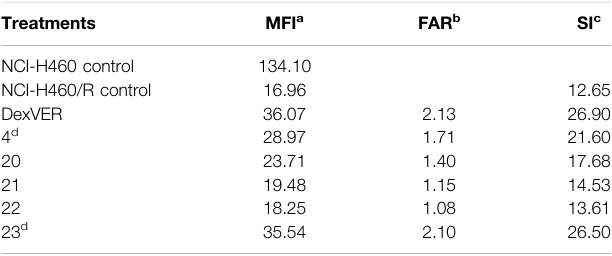
TABLE 2 | Derivative 4 sensitizes the NCI-H460/R cell line to doxorubicin. Combined treatments